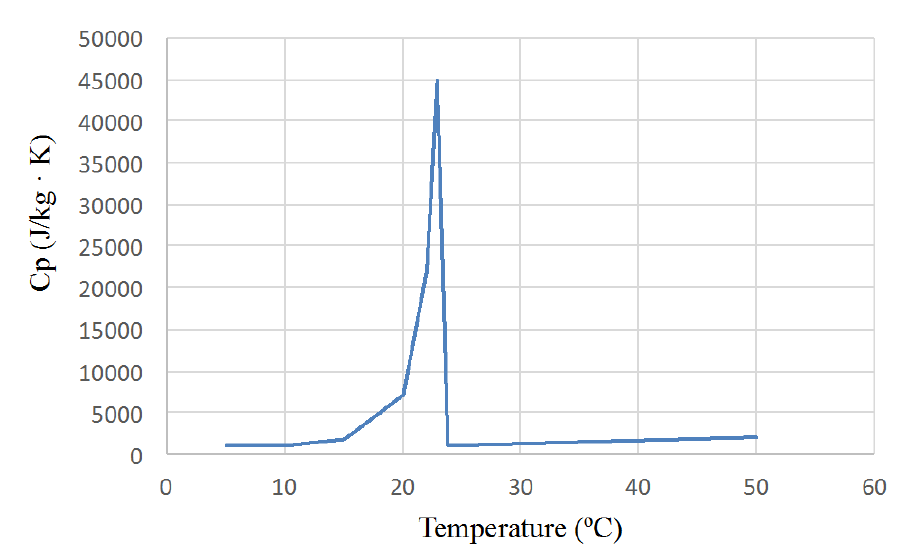
Figure 4. Effective heat